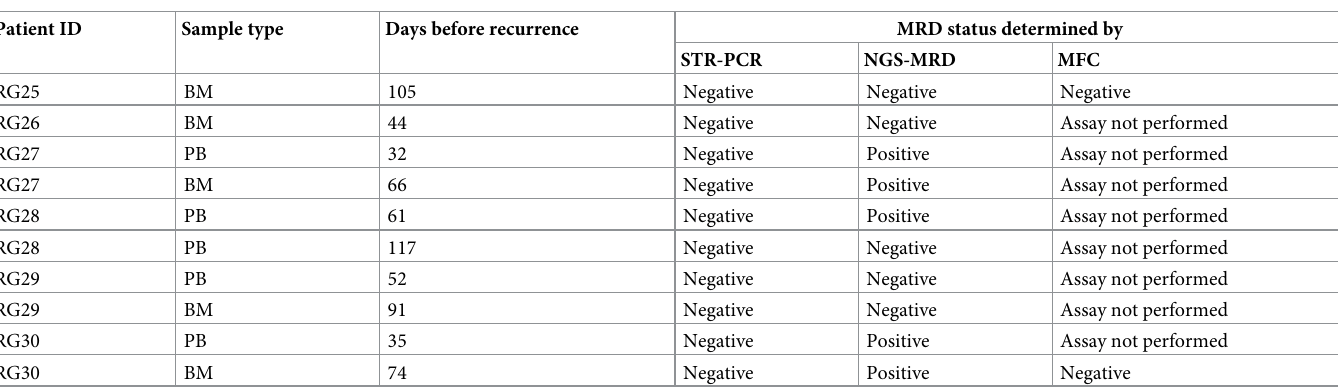
S1 Table. Patient characteristics. S2 Table. NRG samples at a well–engrafted time points MRD negative. S3 Table. The 59 trackable pathogenic variants (47 in RG, 9 in NRG and 3 excluded) and their distribution in the patients in this